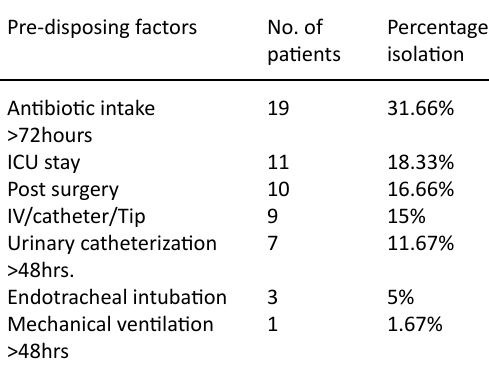
Table 2. Isolation rate of CONS on the basis of